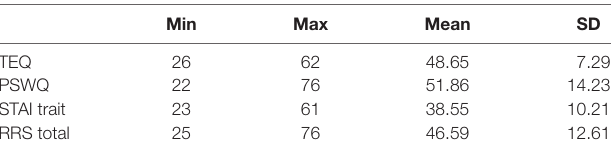
TABLE 1 | Descriptive statistics for questionnaire measures ( N = 49).